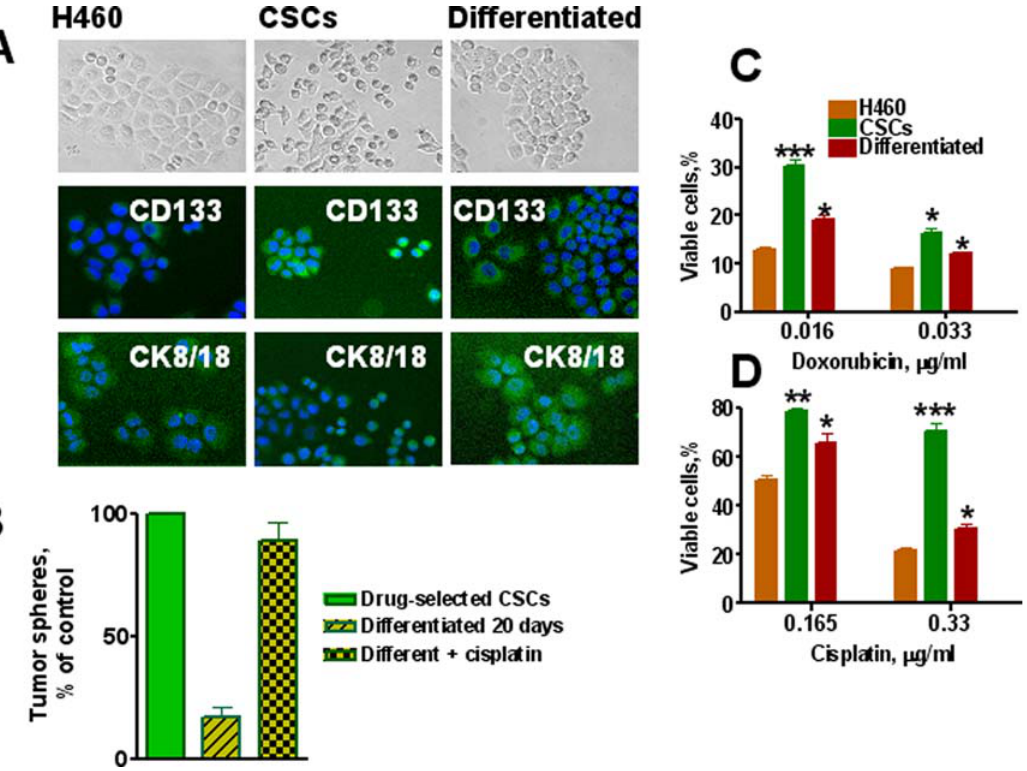
Figure 6. In vitro differentiation potential of lung cancer sphere cells and drug resistance of CSCs. A, Loss of stem cell marker (CD133) and increase of differentiation markers (CK8/18) by lung CSCs differentiated progenitors. Parental H460 cells and CSCs from tumor spheres were seeded in collagen coated well plates and cultured for 3 weeks in complete RPMI 1640 medium supplemented with 10% FBS. Upper row - cell images in phase –contrast microscopy; in the middle - cells immunofluorescently stained for CD133 and bottom row - cells immunofluorescently stained for CK 8/18. B, Self-renewing ability of differentiated lung cancer cells treated with cisplatin . Relative % of cells generated tumor spheres from single-cell suspension cultures of drug selected CSCs, cells differentiated during 3 weeks and Progenitors of CSCs differentiated for 3 weeks were treated with cisplatin (1 m M) for two days. Surviving cells were transferred into low adherent plates and cultured in semisolid serum free medium supplemented with growth factors. Numbers of formed tumor spheres were determined and presented as percent of control. Control is number of spheres formed by transfer of cells derived from control tumor spheres. Number of these spheres is accepted as 100 %. C, Effect of cisplatin and doxorubicin on proliferation of parental H460 cells, CSCs and their differentiated cells . H460, lung CSCs and differentiated cells were plated in 96-well plates precoated with Collagen at 1 6 10 4 cells/well in complete RPMI 1640 medium with 10% FBS. After 24 h doxorubicin or cisplatin was added at the indicated concentrations. Cells were cultured for 72 h, fixed, stained with Hoechst 33342 (2 m g/mL), and counted using the Cellomics ArrayScan HCS Reader.